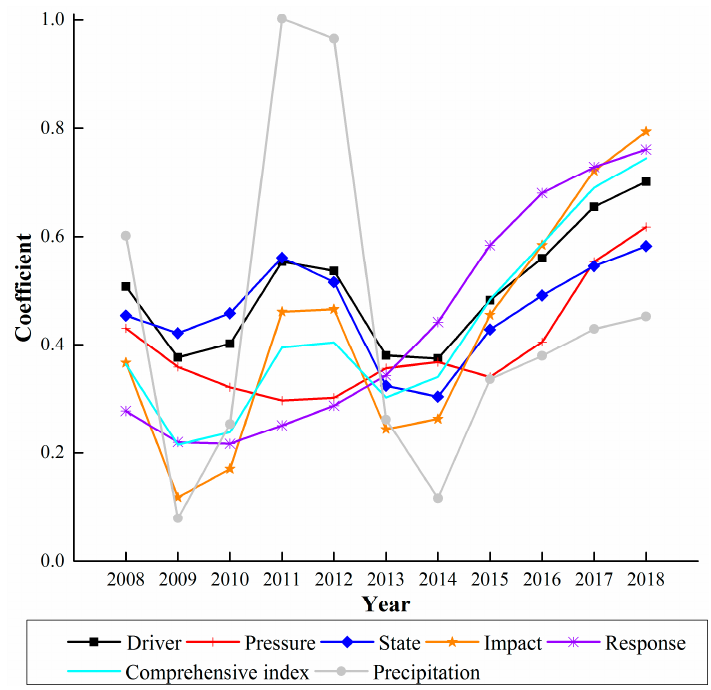
Figure 4. The main fluctuation tendency of the DPSIR indexes and the precipitation.